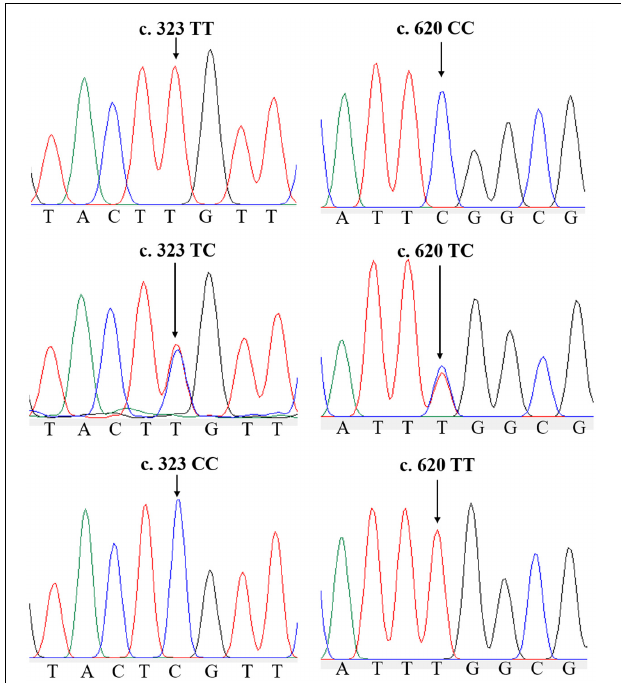
FIGURE 1 | Two single-nucleotide polymorphisms (SNPs) of Sc-GDH gene. Peaks of normal and two mutated forms of c.323T > C and c.620C > T locus in Sc-GDH .